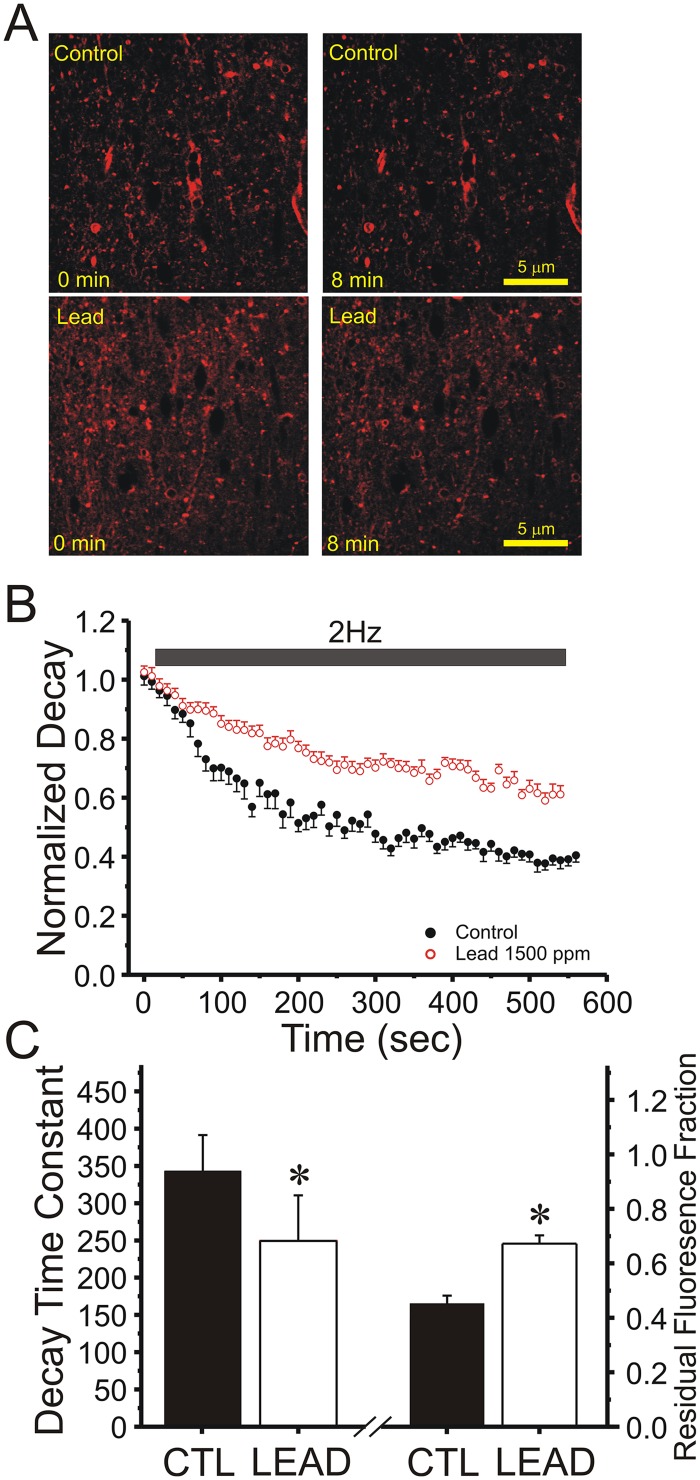
Two-photon laser scanning microscopic (TPLSM) images of FM1-43 vesicular release from Schaffer collateral terminals in field CA1 of hippocampal slices confirm that release probability is reduced by chronic Pb2+ exposure.(A) Representative TPLSM pseudocolor images of FM1-43 loaded presynaptic terminals in stratum radiatum of field CA1 in hippocampal slices from Pb2+-treated and control rats imaged prior to (0 min) and after 8 minutes (8 min) of 2Hz Schaffer collateral stimulation (Calibration Bar: 5 μm). (B) Time course (Mean ± SEM) of stimulus-evoked FM1-43 destaining from puncta in field CA1 of hippocampal slices in response to 2Hz Schaffer collateral stimulation (solid bar) in control (black circles, N = 8 slices, 35 puncta) versus Pb2+-treated (red circles, N = 6 slices, 30 puncta) rats. (C) Mean ± SEM of initial decay time constant (left bars) and ending residual fluorescence (right bars) in the slices in (B) from control (CTL) versus Pb2+-treated (LEAD) rats (*,P <0.05, Student’s t-test), showing slower destaining of Schaffer collateral terminals from rats chronically exposed to Pb2+.